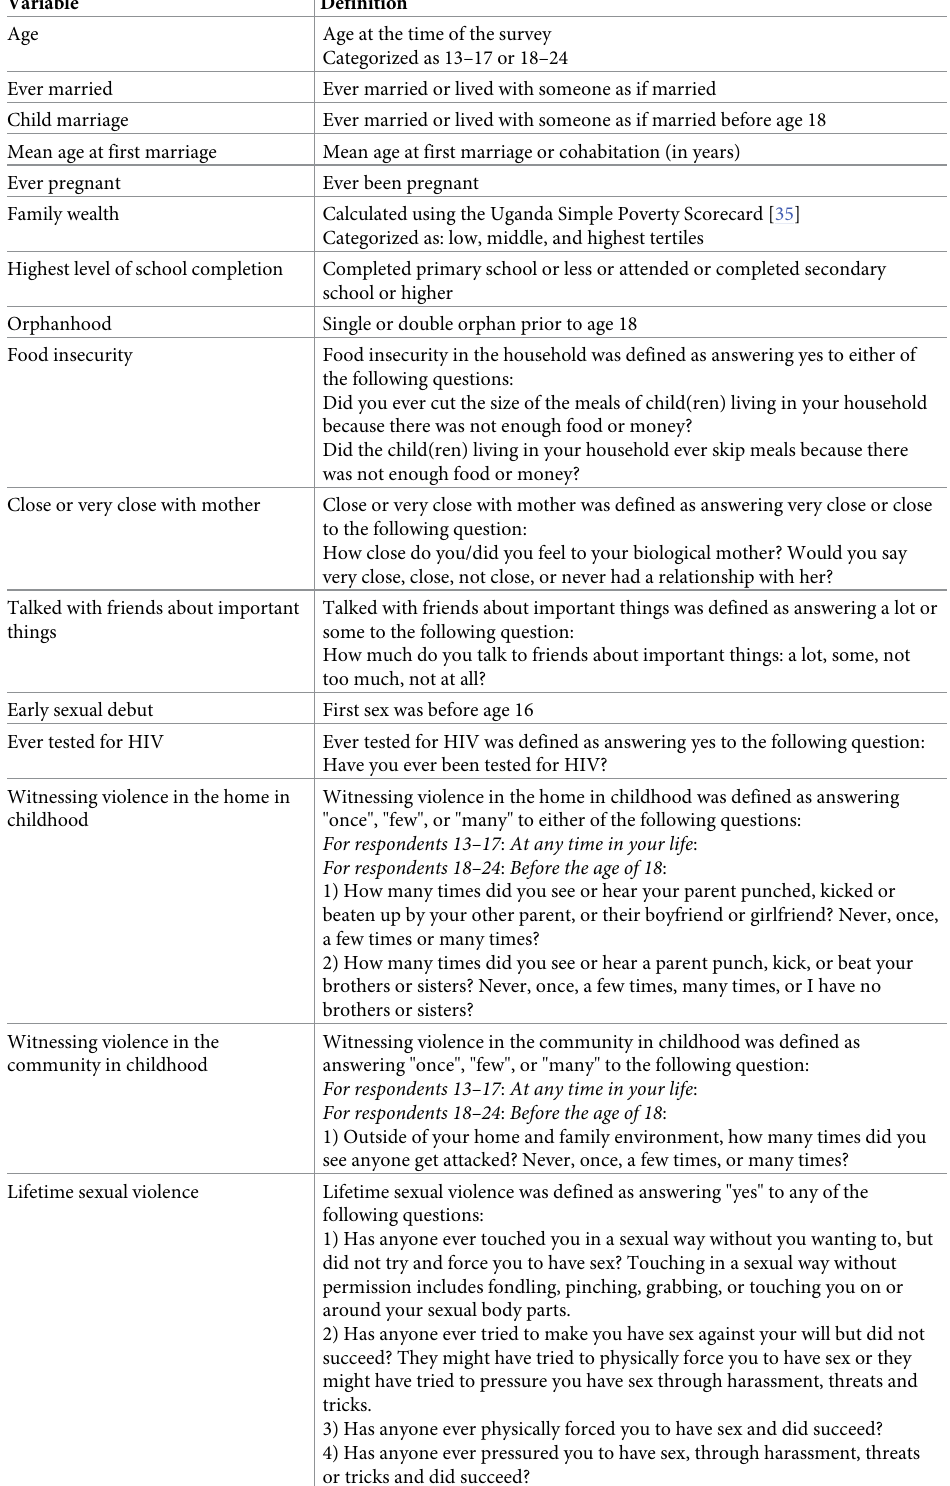
Table 1. Definitions of sociodemographic factors and violence and violence-related